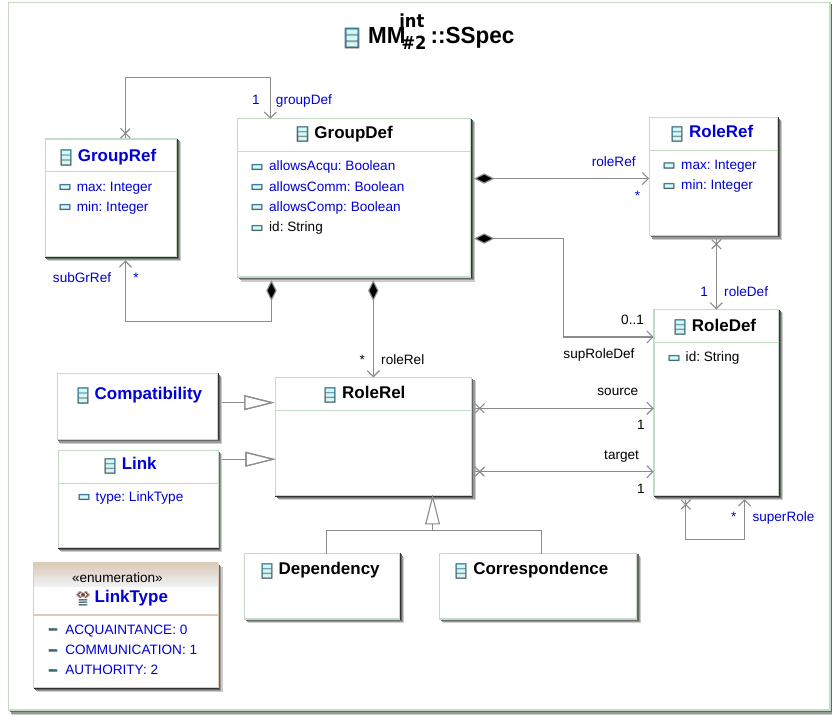
Figure 9. Integrated metamodel MM int